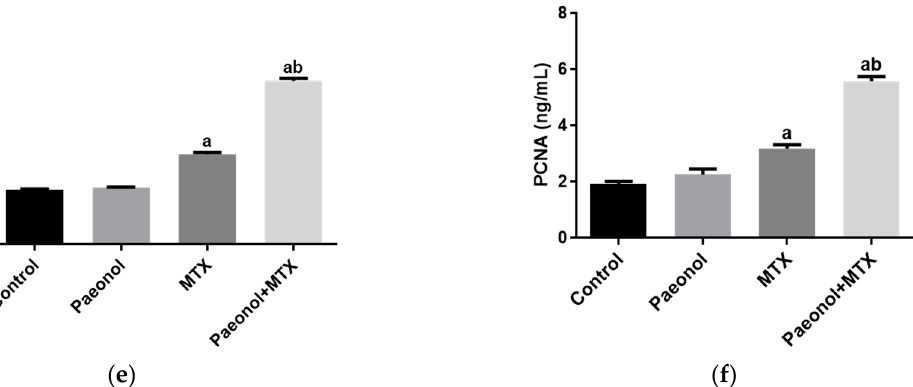
Figure 6. The immunohistochemical examination of hepatic proliferating cell nuclear antigen (PCNA) expression in methotrexate (MTX)-induced hepatotoxicity (×400). The liver tissues of the control ( a1 , a2 ) and paeonol ( b1 , b2 ) groups show hepatocytes (black arrows) and Kupffer cells (yellow arrows) with PCNA-positive nuclei. Notice the positive endothelial cells lining the central veins (CV) (blue arrows) and portal tracts (PT) (green arrows). The liver tissues of the MTX-treated rats show apparent numerous PCNA-positive nuclei in hepatocytes (black arrow), Kupffer cells (yellow arrow), and endothelial cells lining the CV (blue arrow) and the PT (green arrow) with intense nuclear expression ( c1 , c2 ). The liver tissues of the paeonol + MTX group show more numerous PCNA-positive nuclei in the same cells ( d1 , d2 ). A semi-quantitative analysis of PCNA positive cells ( e ). Hepatic PCNA level using PCNA ELISA kit ( f ). Data are represented as mean ± SEM ( n = 6). Letters a,b Denote significant differences from the normal control and the MTX groups, respectively, at p < 0.05.